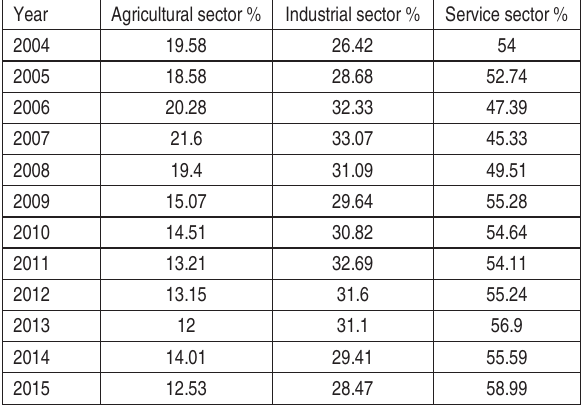
Table 1. Percentage contribution to GDP by